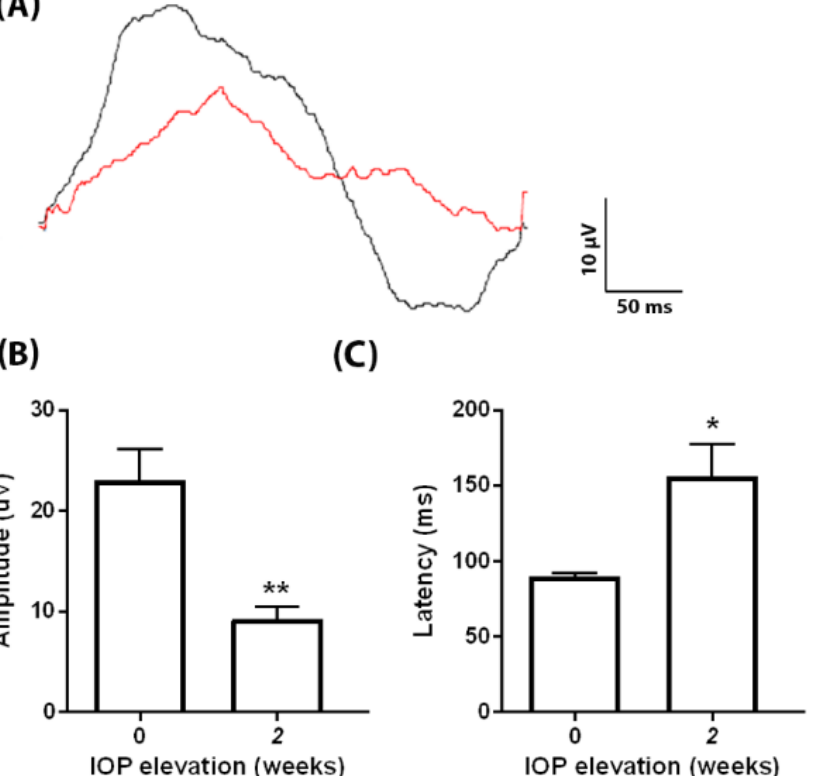
Figure 5. PERG reduction in egl1 mice. ( A ) Representative PERG waveforms recorded from egl1 mice before (black) and 2 weeks after (red) IOP elevation. IOP elevation decreased and delayed the PERG response. ( B , C ) Bar graphs show decreased PERG responses ( B ) and increased PERG latencies ( C ) after 2 weeks of IOP elevation. Data are presented as means ± SEM ( n = 5–6) *: p < 0.05, **: p < 0.01.